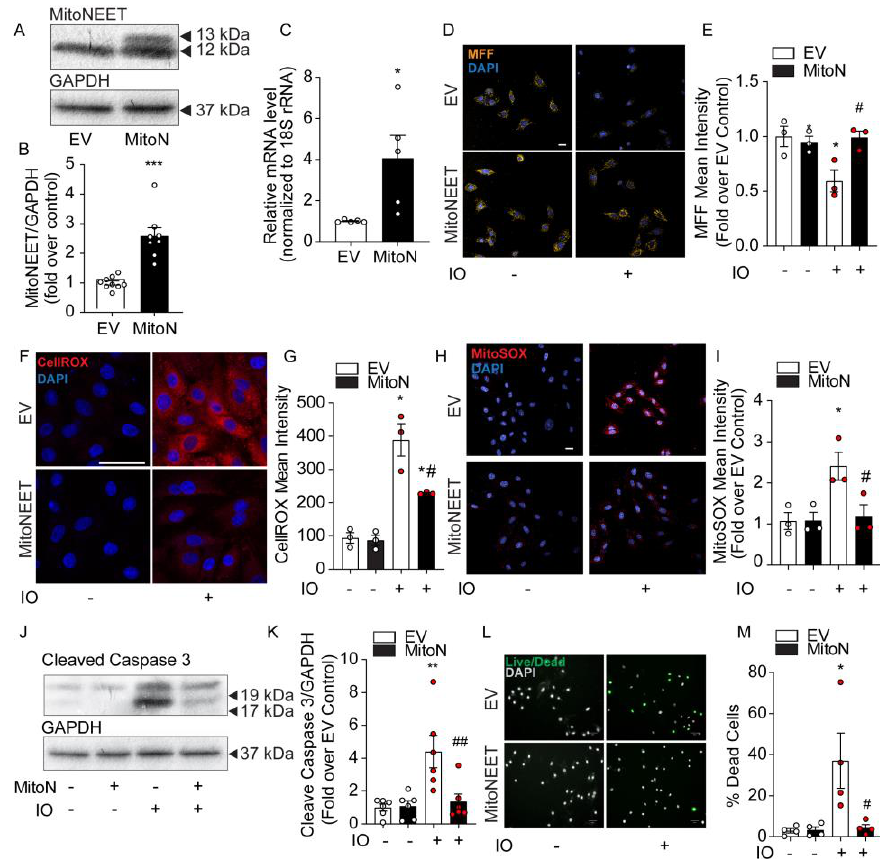
Figure 4. MitoNEET overexpression lowers cellular and mitochondrial ROS and protects H9c2 cell viability under conditions of iron overload. Characterization of MitoNEET overexpression in H9c2 cells. Control cells (EV) and MitoNEET overexpressing cells (MitoN) were treated with FeSO 4 (100 µ M, 24 h). ( A ) Western blotting for MitoNEET in EV and MitoN cells showed expression of the exogenous flagged-tagged MitoNEET (13 kDa) relative to the endogenous version (12 kDa). ( B ) Densitometric quantification of total MitoNEET expression relative to GAPDH using ImageJ software. ( C ) MitoNEET mRNA quantification (relative to 18S rRNA) by qPCR in EV and MitoN cells (n = 5). ( D ) Confocal images of mitochondrial MFF fluorescent dye in EV and MitoN cells under IO is quenched in proportion to labile mitochondrial iron levels. ( E ) Quantification of MFF pixel intensity (n = 3). ( F ) Analysis of ROS production in EV and MitoN cells under IO, as detected by CellROX Deep Red. ( G ) Quantification of CellROX Deep Red pixel intensity (n = 3). ( H ) Analysis of mitochondrial ROS by confocal analysis using MitoSOX Red. ( I ) Quantification of MitoSOX Red pixel intensity (n = 3). ( J ) Western blot analysis of the apoptotic protein biomarker, cleaved-Caspase 3, under IO in EV and MitoN cells. ( K ) Densitometric quantification of total MitoNEET expression relative to GAPDH using ImageJ software (n = 7). ( L ) Assessment of cell viability with ReadyProbes Cell Viability Imaging Kit. ( M ) Quantification of ReadyProbes positive cells is expressed as a % of total cells (n = 4). Scale bar denotes 20 µ m for D, H, and F, and 50 µ m for L. * p < 0.05, ** p < 0.01, *** p < 0.001 relative to EV Control; # p < 0.05, ## p < 0.01, relative to EV +